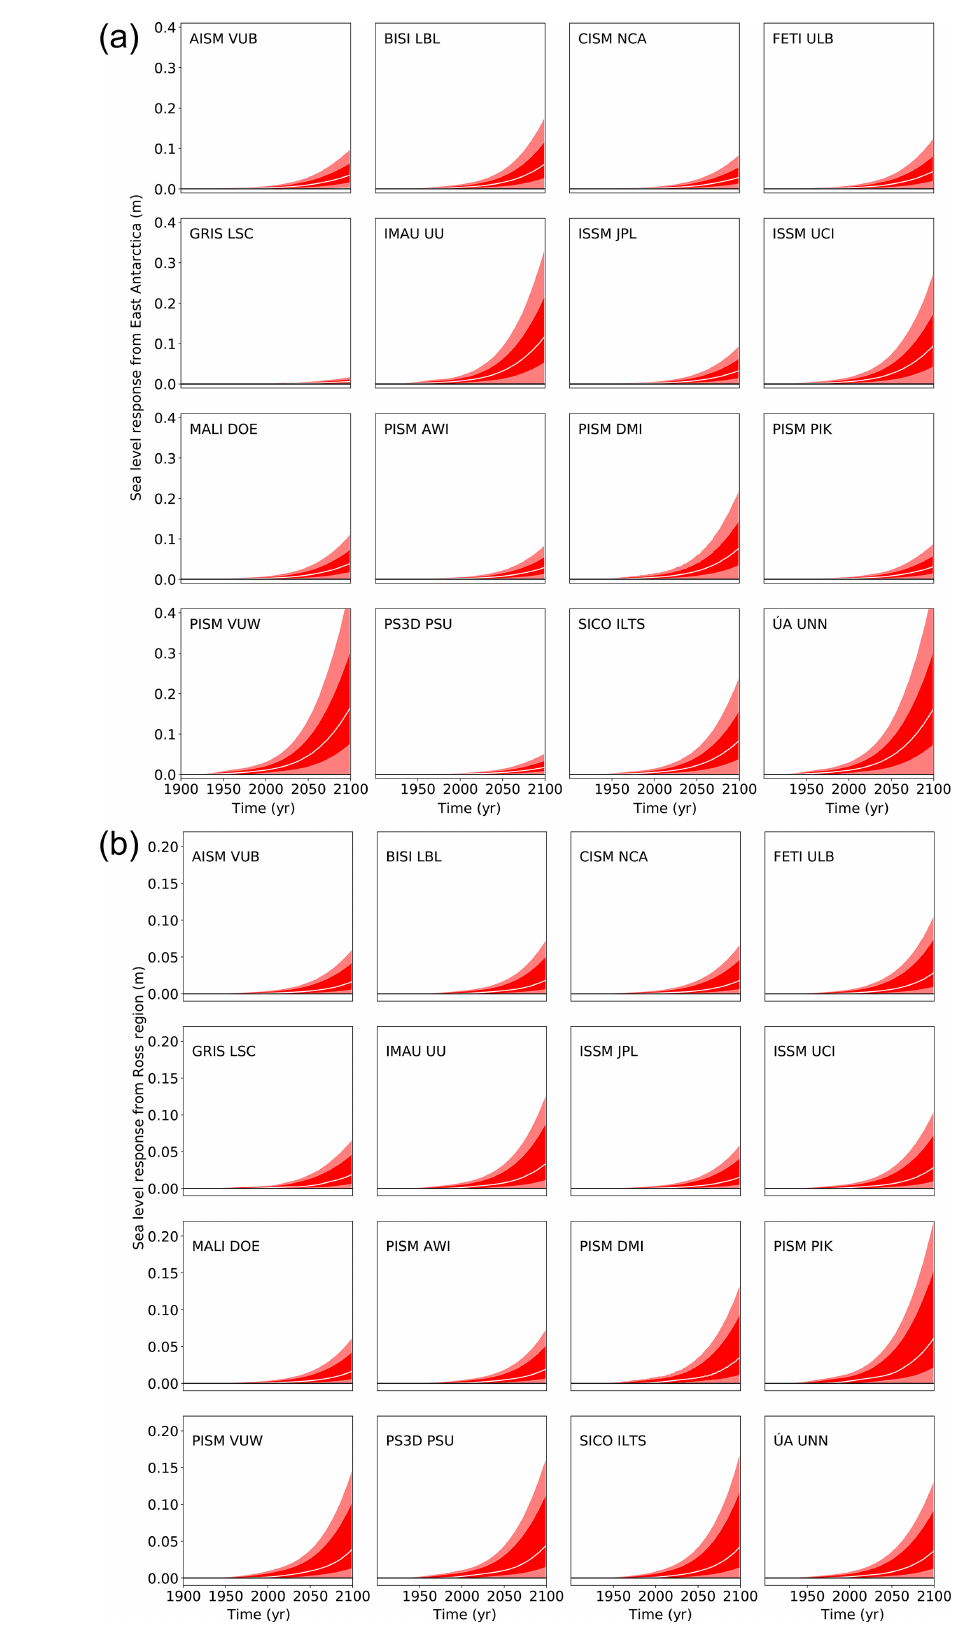
Earth Syst. Dynam., 11, 35–76, 2020